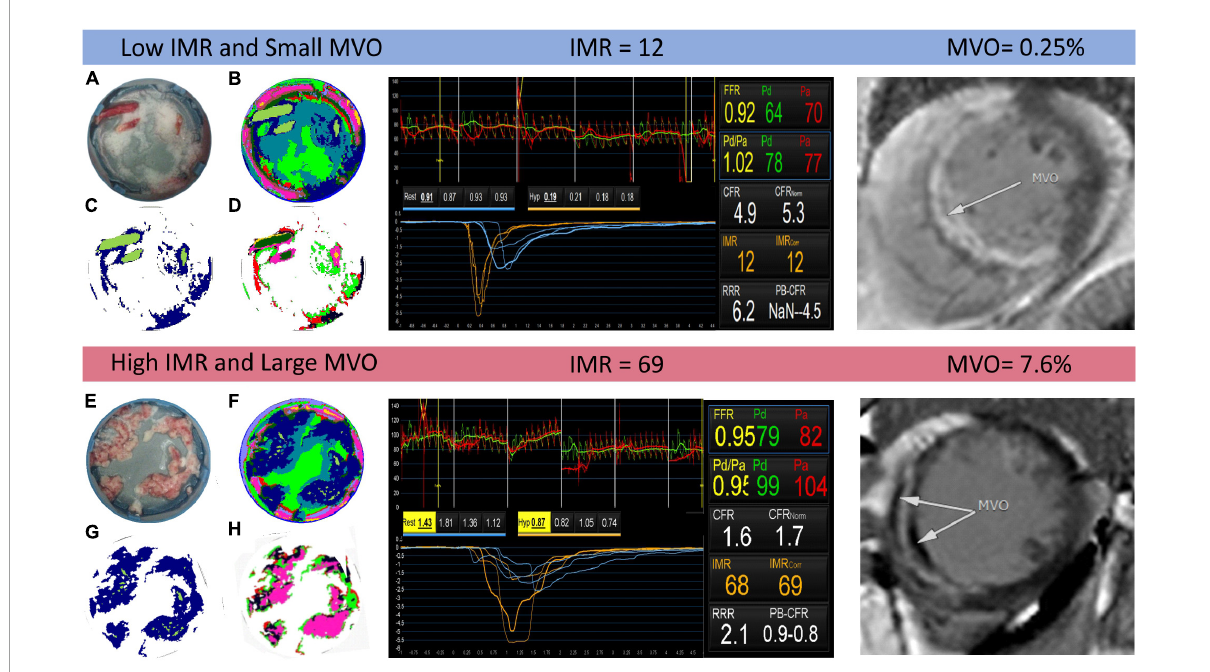
FIGURE4 Example output of the k -means clustering analysis for two patients identified as having low and high index of coronary microvascular resistance (IMR) (centre panel) and small and large microvascular obstruction (MVO) (right panel), respectively. In the left panel, images (A,E) are photographs of the thrombus samples for each patient; images (B,F) show the results of the K = 11 k -means clustering analysis, with each colour corresponding to a different cluster; images (C,G) are the same as images (B,F) but with all non-thrombus pixels set to zero; and images (D,H) show the results of a second k -means clustering analysis with K = 7, performed only on thrombus pixels.